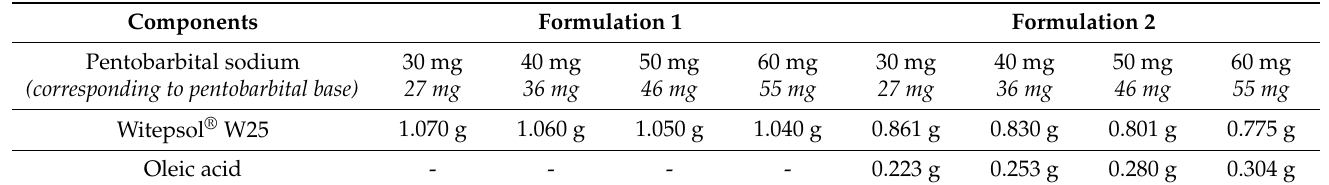
Table 1. Composition of pentobarbital suppositories (quantities for one suppository). Components Formulation